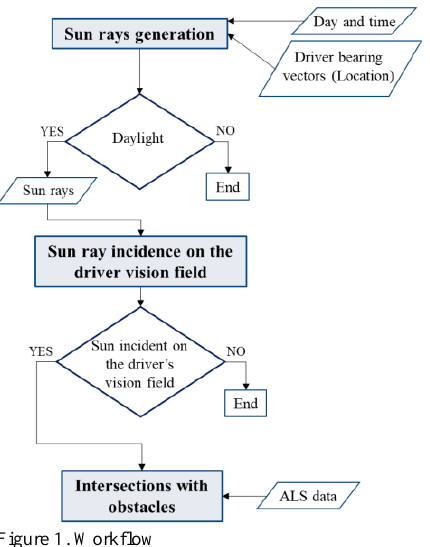
Figure 1. Workflow